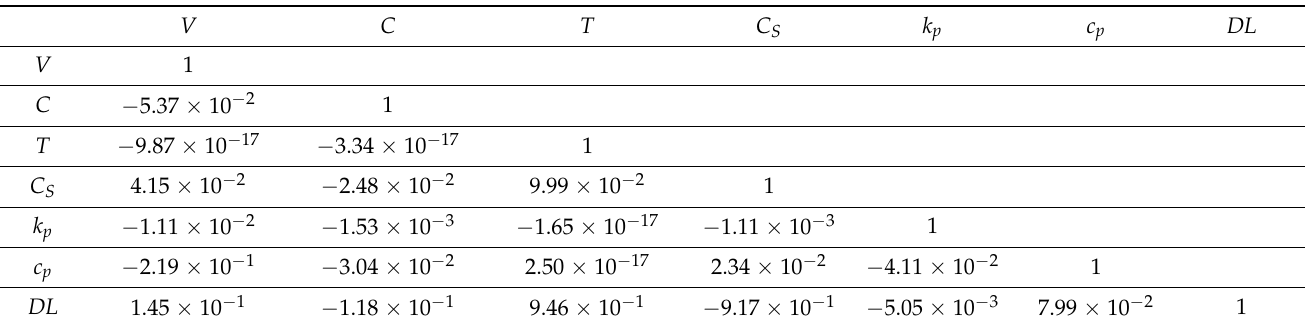
Table 5. Correlation matrix between train–track properties.